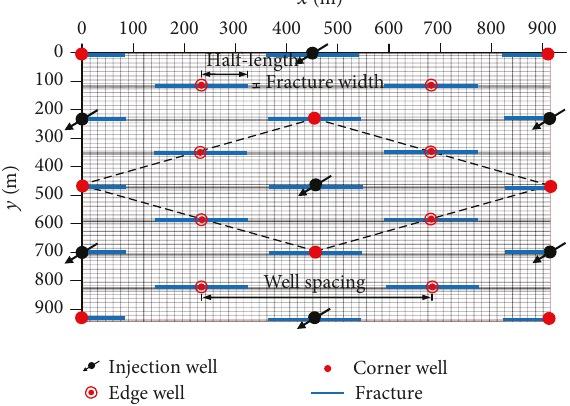
Figure 1: Grid model and well pattern illustration.